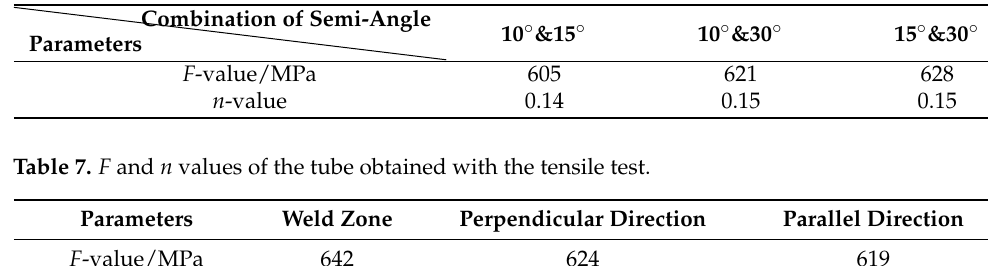
Table 6. F and n values of the tube calculated with Equations (26) and (27).